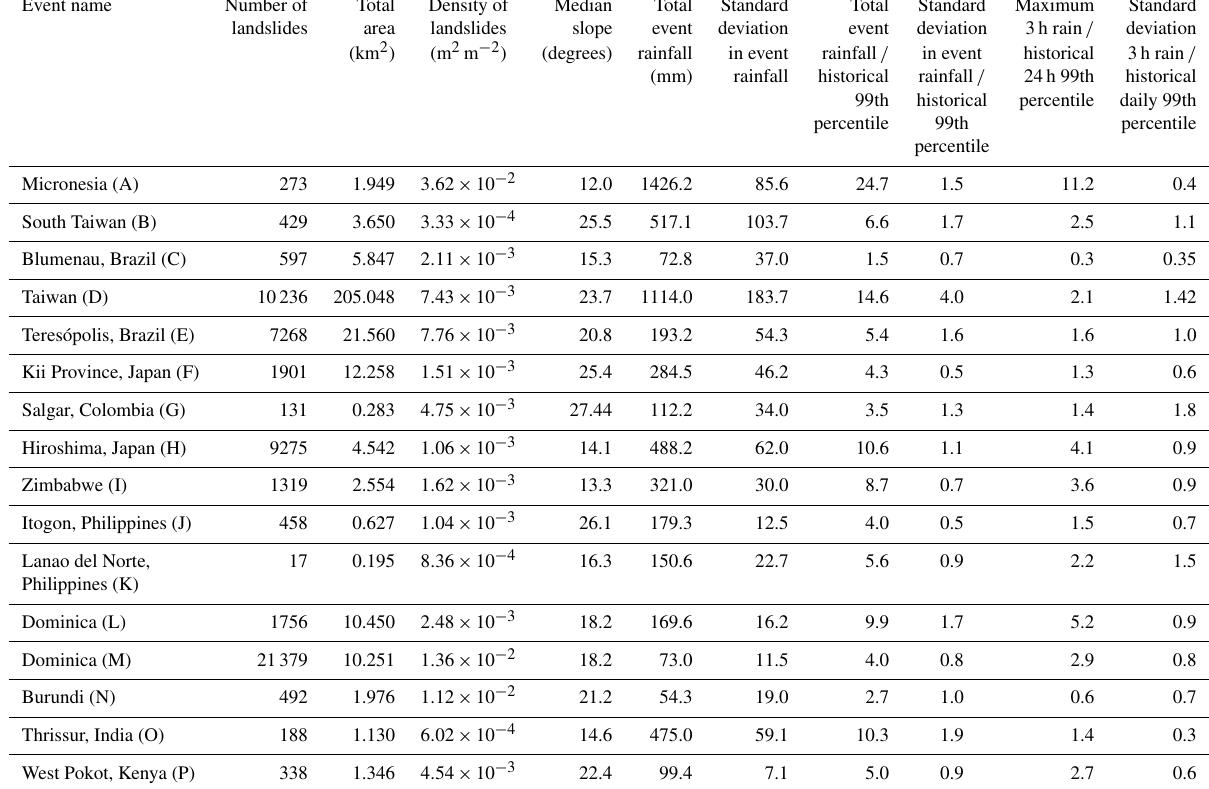
Table 2. Macro-level characteristics for events discussed, including rainfall statistics. Note that median slope values have been calculated by excluding very low slope values ( < 1 ◦ ) to remove lakes and